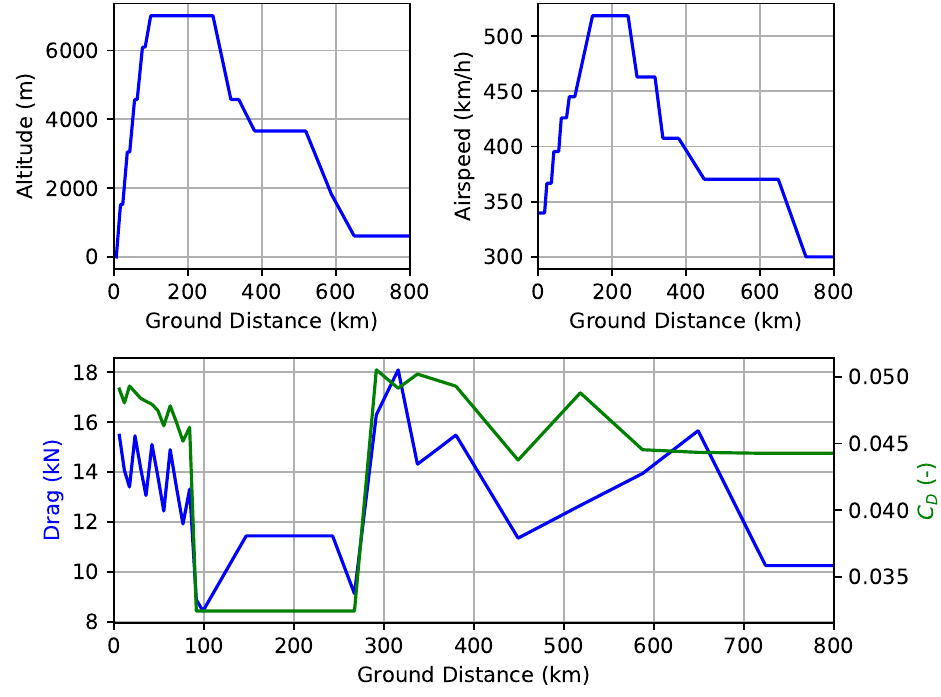
Figure 2. Considered mission profile in terms of altitude ( top left graph), airspeed ( top right graph), and total drag force and coefficient (bottom graph, identified by blue and green colors,